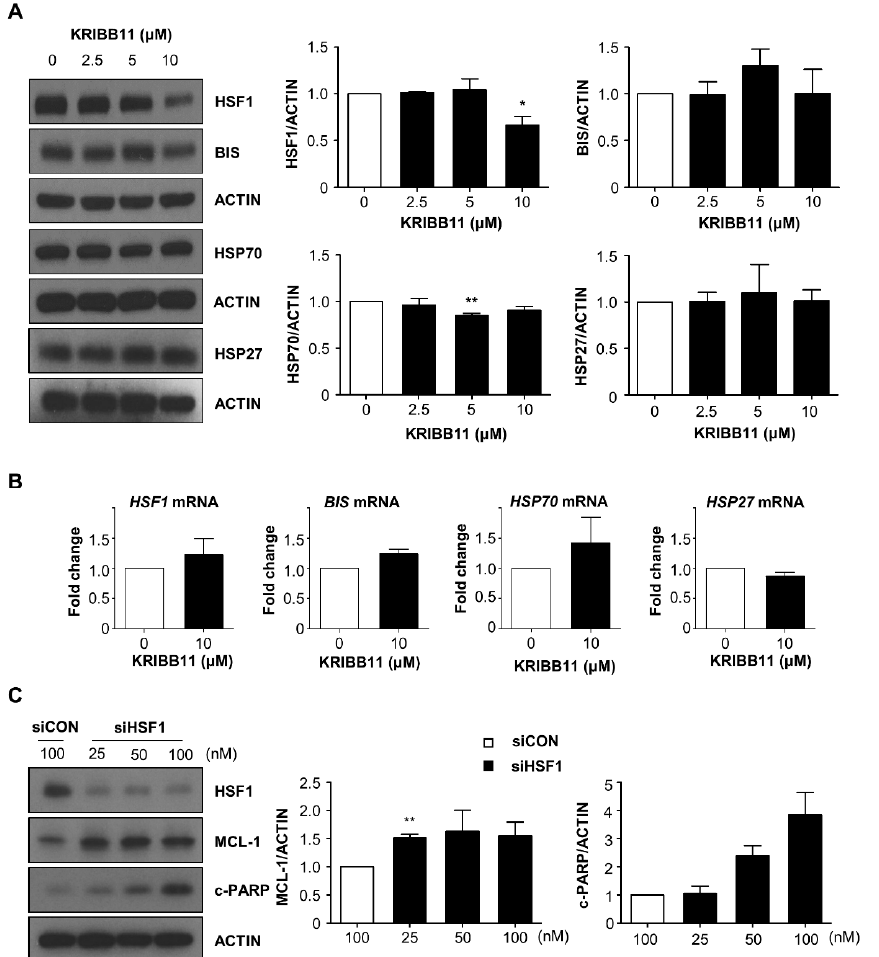
Figure 3. Effect of KRIBB11 on the expression of HSF1 and its target proteins. ( A ) Following treatment with KRIBB11 with the indicated dose, the expression of HSF1 and HSP70 was examined by Western blotting ( left ). Densitometry analysis for HSF1 and HSP70 from three independent experiments was shown in right column. ( B ) The mRNA levels of HSF1 , BIS , HSP70, and HSP27 were determined by qRT–PCR analysis. ( C ) HSF1 expression was suppressed by siRNA (siHSF1) in A172 cells, and the expression of MCL-1 and c-PARP levels were determined by Western blotting analysis ( left ). The relative levels of MCL-1 and c-PARP were determined by densitometry analysis. The value from A172 cells transfected with control siRNA (siCON) was designated as 1.0. Data are mean ± SE of three independent experiments. * p < 0.05, and ** p < 0.01 vs. control values.